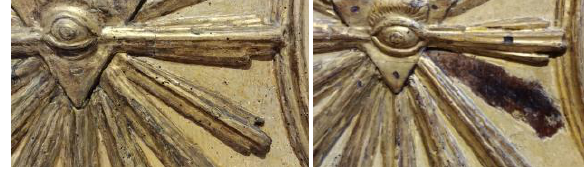
Figure 5. Sunbeam.